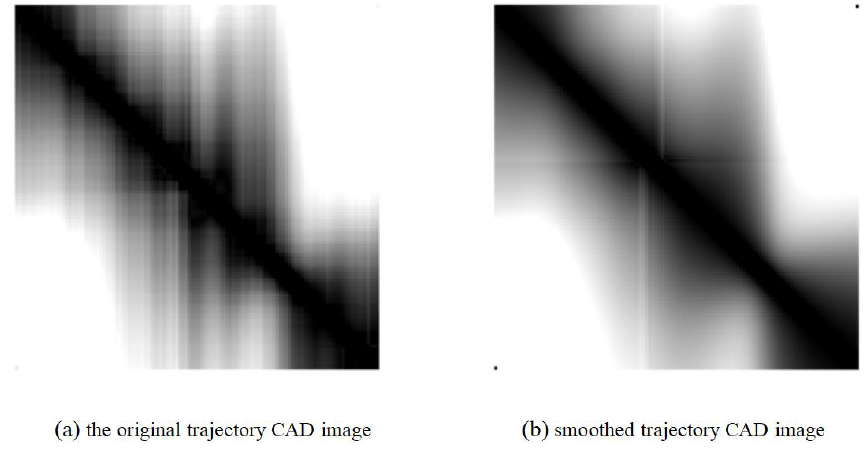
Figure 6. CAD descriptor of the two trajectories in Fig.